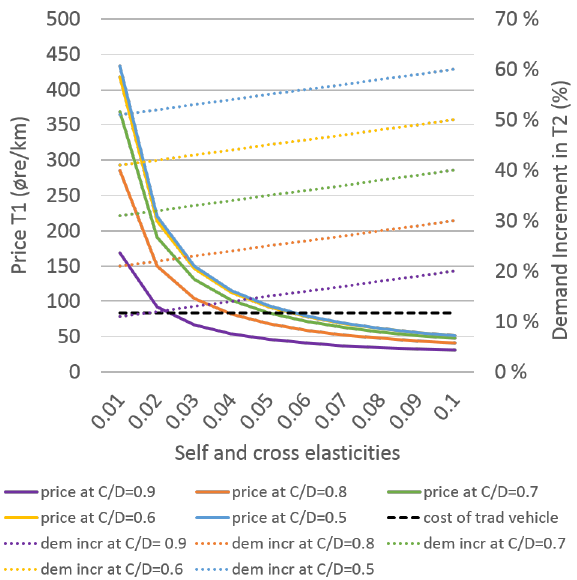
Figure 6. Effect of the cross-elasticity T 2 T 1 on the